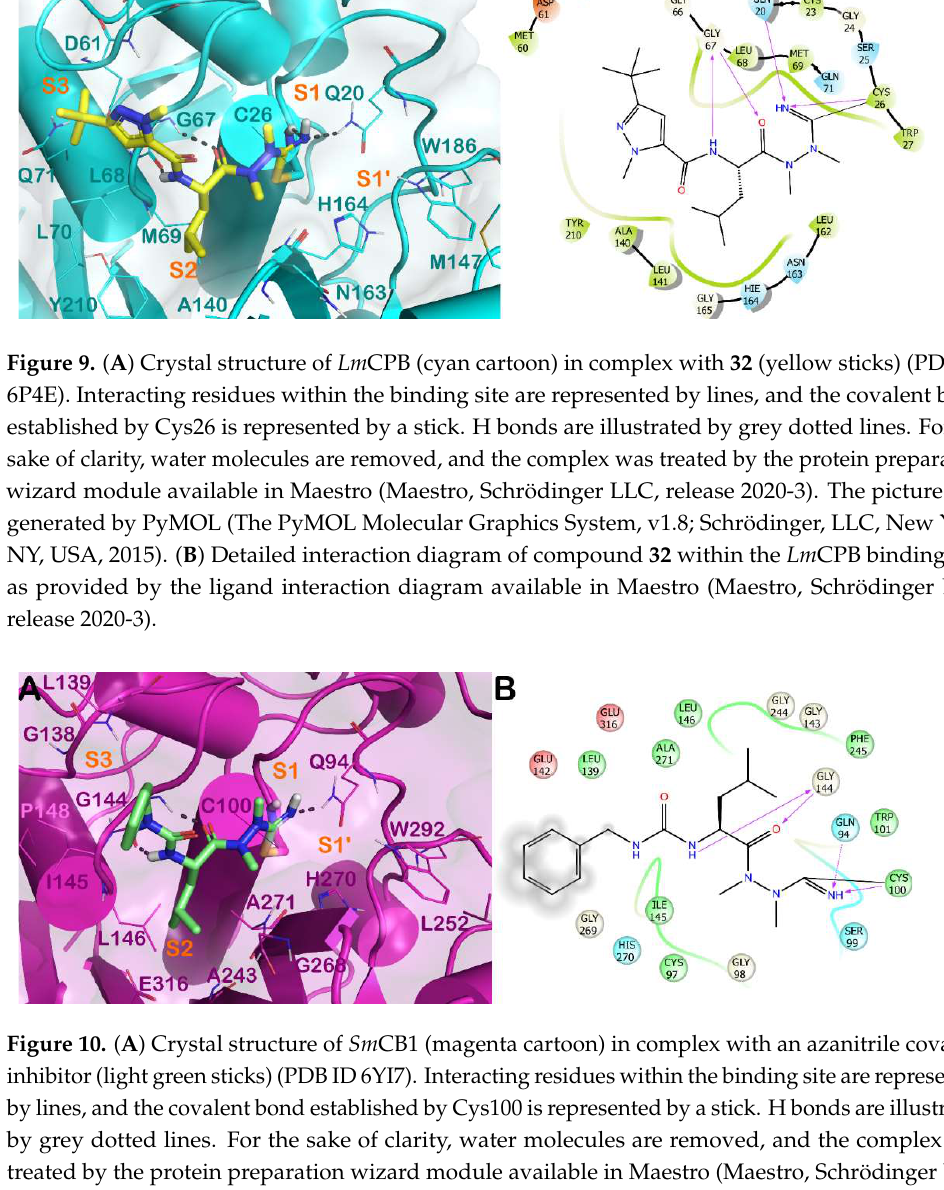
Figure 10. ( A ) Crystal structure of Sm CB1 (magenta cartoon) in complex with an azanitrile covalent inhibitor (light green sticks) (PDB ID 6YI7). Interacting residues within the binding site are represented by lines, and the covalent bond established by Cys100 is represented by a stick. H bonds are illustrated by grey dotted lines. For the sake of clarity, water molecules are removed, and the complex was treated by the protein preparation wizard module available in Maestro (Maestro, Schrödinger LLC, release 2020-3). The picture was generated by PyMOL (The PyMOL Molecular Graphics System, v1.8; Schrödinger, LLC, New York, NY, USA, 2015). ( B ) Detailed interaction diagram of a covalent inhibitor within the Sm CB1 binding site, as provided by the ligand interaction diagram available in Maestro (Maestro, Schrödinger LLC, release 2016).